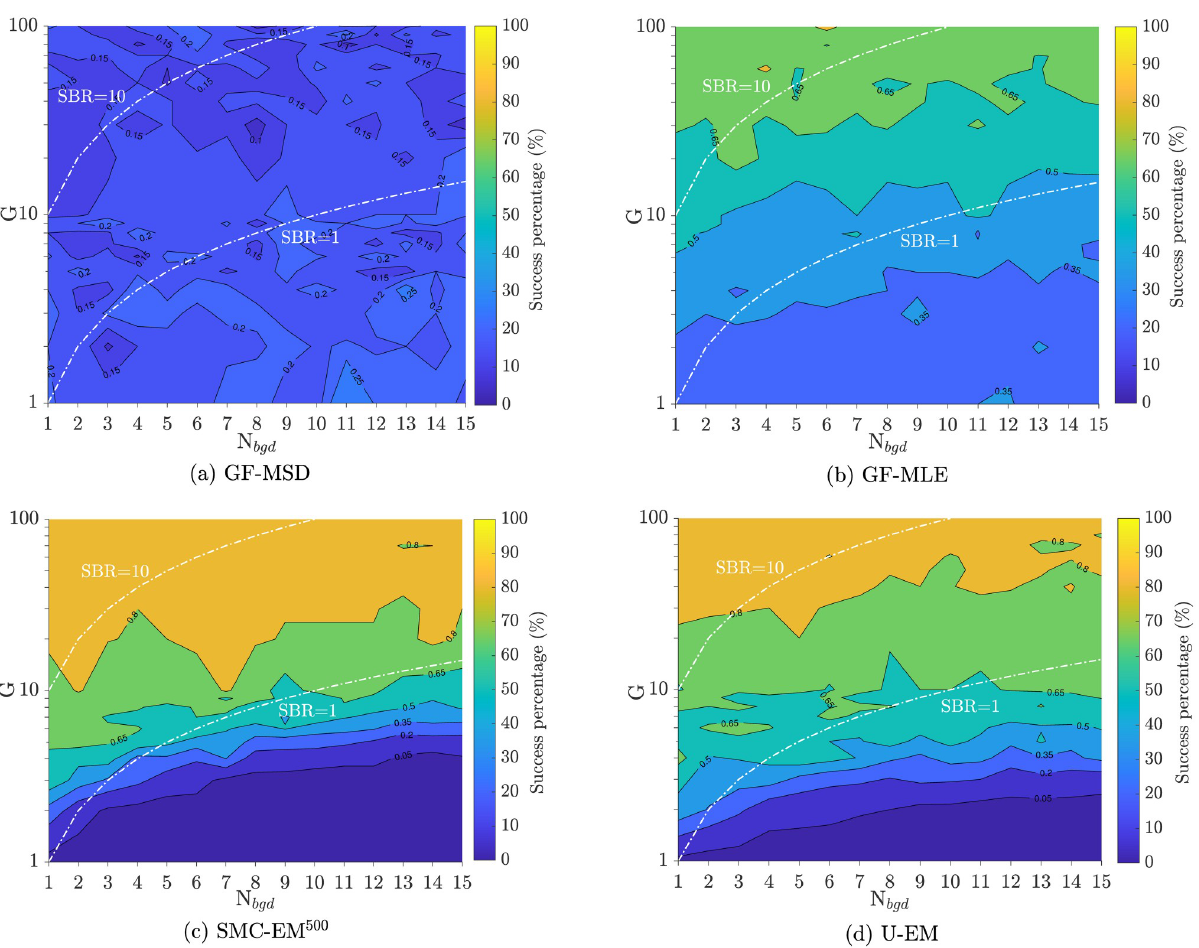
Fig 7. Success maps of the four algorithms. The percentage of trajectories resulting in an estimated D peak intensity G and background level N is shown. Yellow indicates 100% success while blue represents 0%. Results along the two white curves are bgd shown in Fig 8.